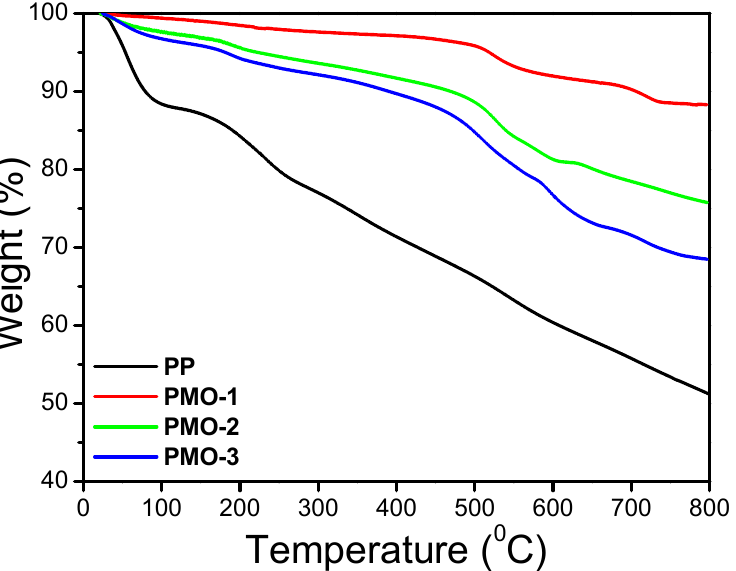
Figure 3. TGA spectra of PP, PMO-1, PMO-2, and PMO-3.